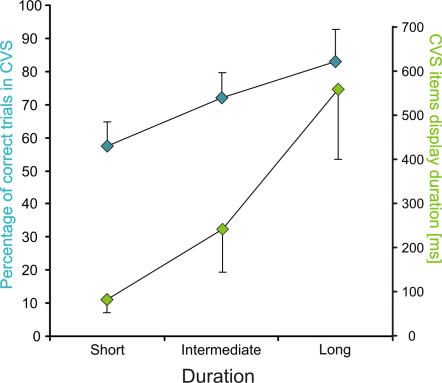
CVS performance as a function of display duration.Percentage of correct trials in CVS (cyan) and mean CVS items display duration (green) for each of the three duration conditions.